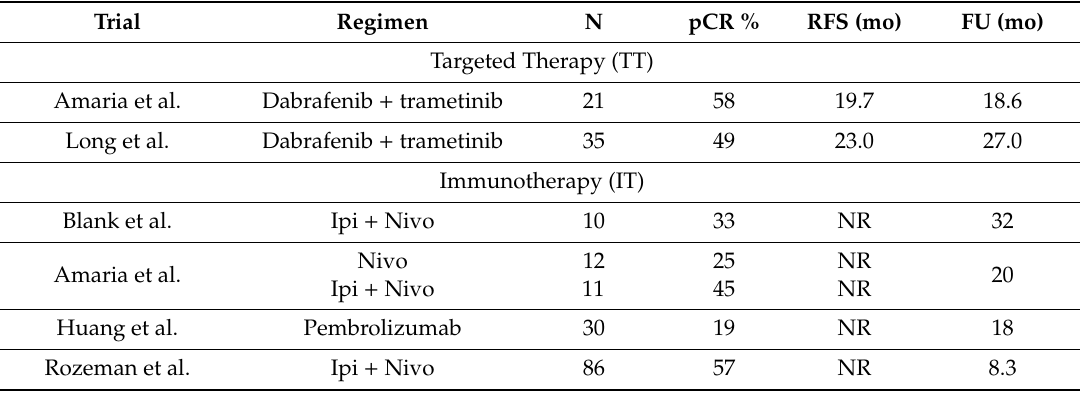
Table 2. Summary of neo-adjuvant trial